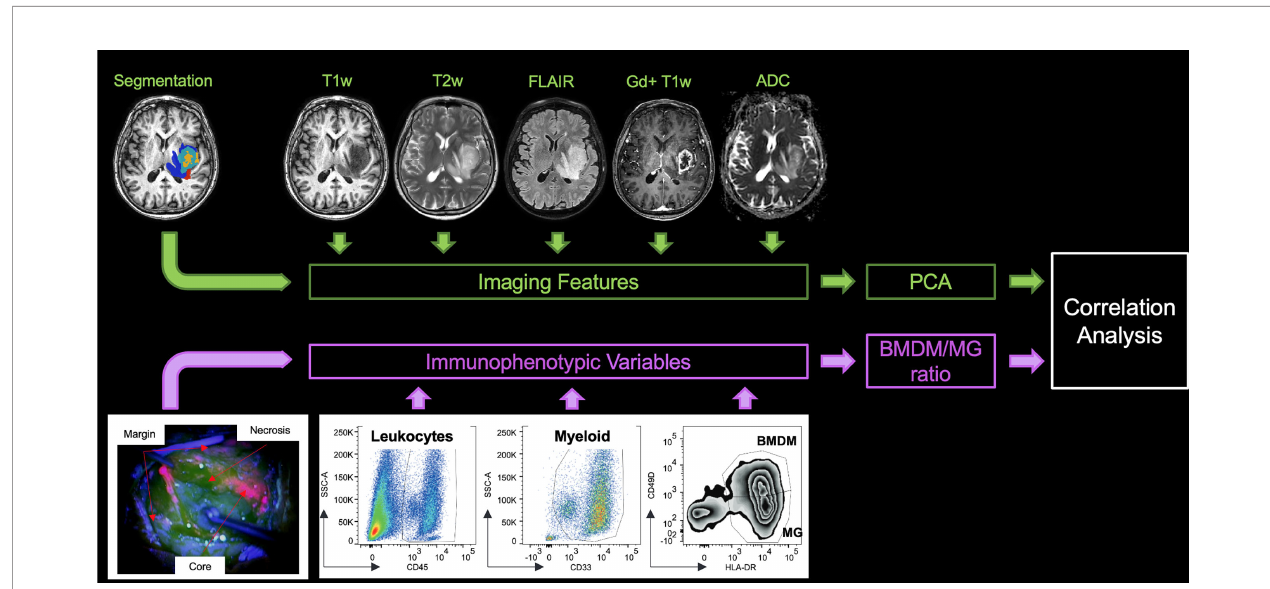
FIGURE 1 | Study design. In the upper left-hand corner, the lesion segmentation superimposed onto the T1w image of the patient highlights the non-enhancing tumor core (red), the enhancing tumor core (light blue), the necrosis (yellow), and the edema (blue). At the top of the fi gure are the fi ve MRI sequences from which the features were extracted. In the bottom left-hand corner, an example of the different surgical samplings according to 5-ALA fl uorescence emission is shown. A representative example of the gating strategy to identify myeloid cell populations is shown in the lower part of the fi gure. PCA, principal component analysis, BMDM, bone marrow-derived macrophage, MG,